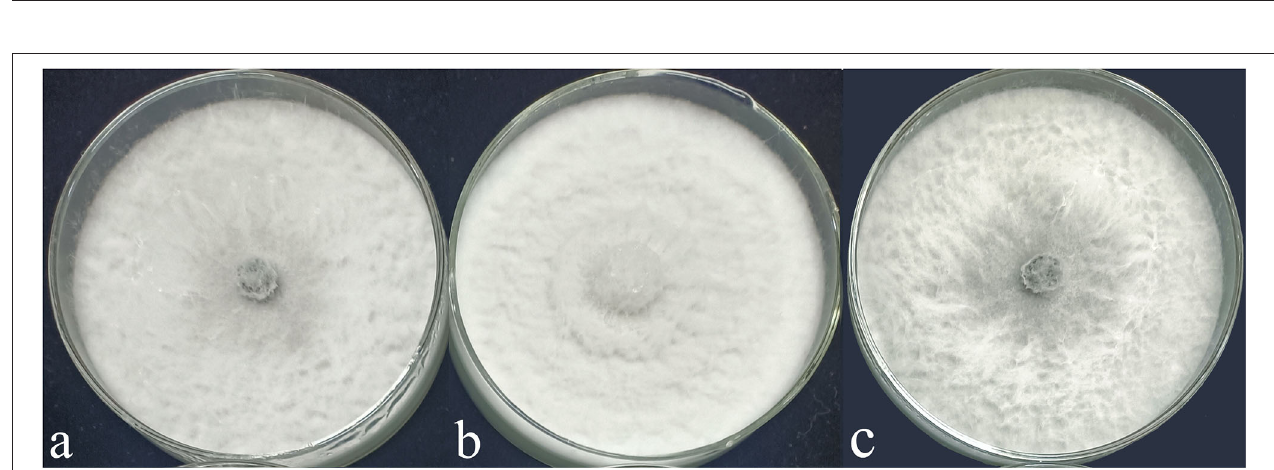
FIGURE 8 | Colony of wild-type, deletion mutant and complementary strains of N. parvum cultured for 5 days. (a) , wild-type strain; (b) , deletion mutant strain; (c) , complementary strain; culture conditions: 25 ◦ C light–dark alternation for 12h.